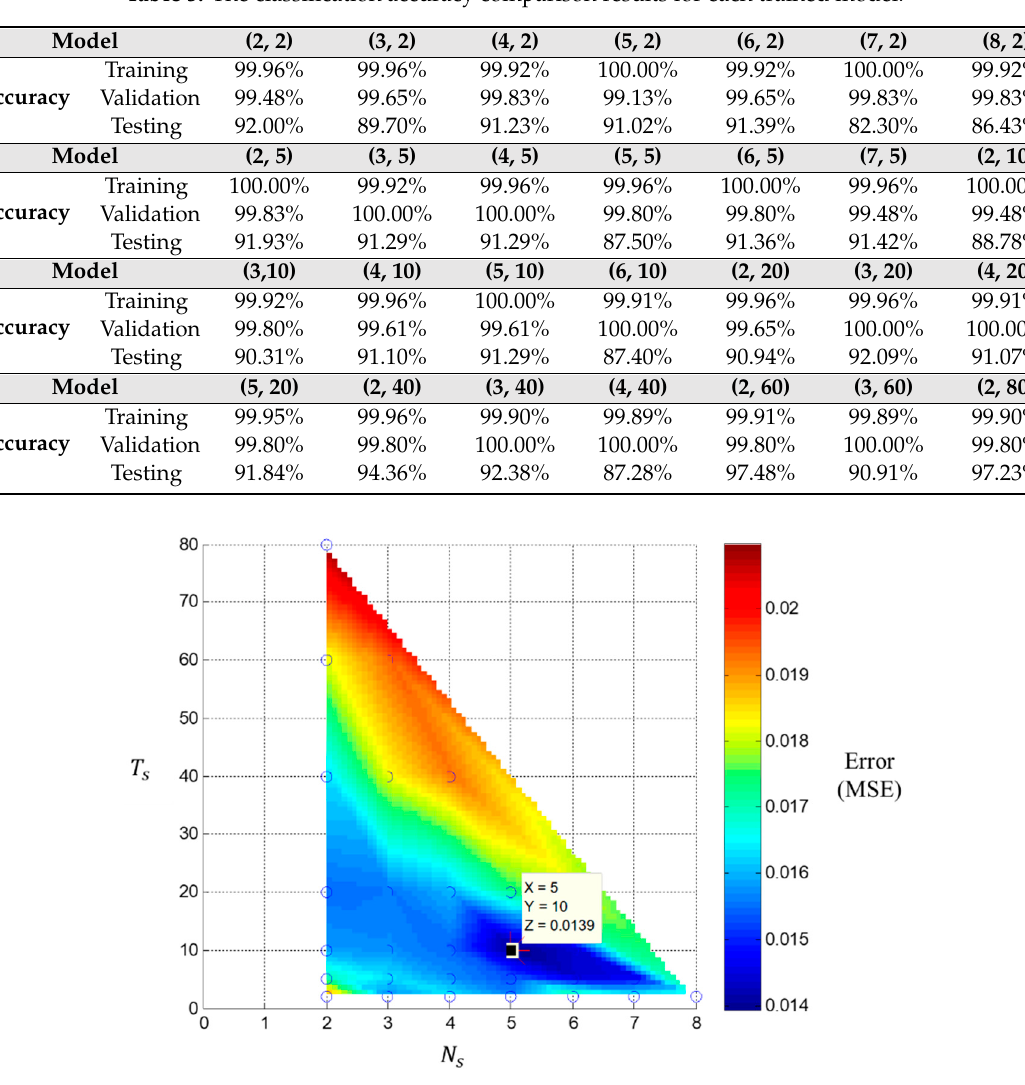
Figure 8. The training bearing remaining useful life (RUL) ratio estimation error comparison